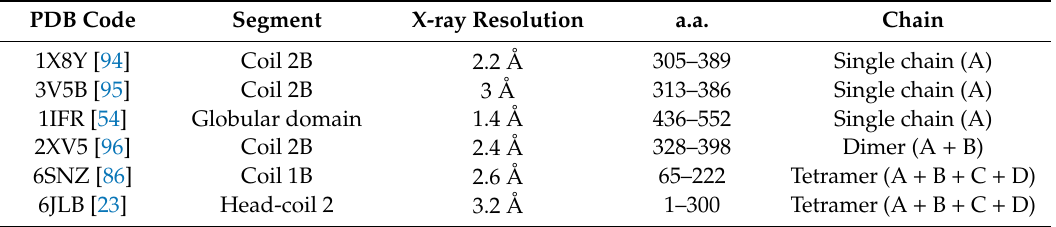
Table 1. Wild type human lamin A / C fragments obtained by X-ray.